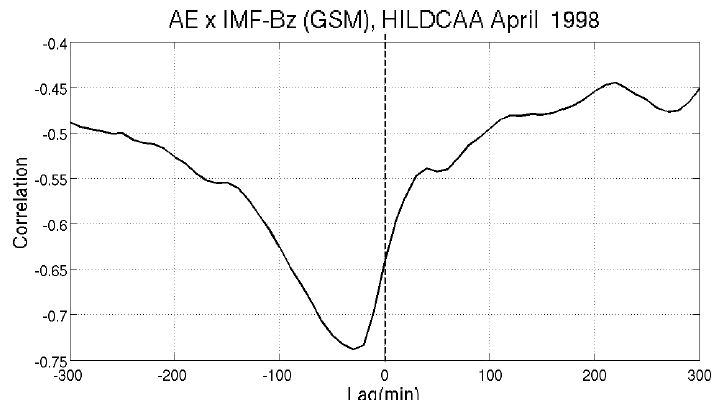
Figure 3. Classical cross correlation between IMF B z and AE index during the HILDCAA event from 17:11UT on 24 April to 16:46UT on 27 April 1998. Maximum cross-correlation coefficient ( r =− 0.74) is found at a lag =− 30min.